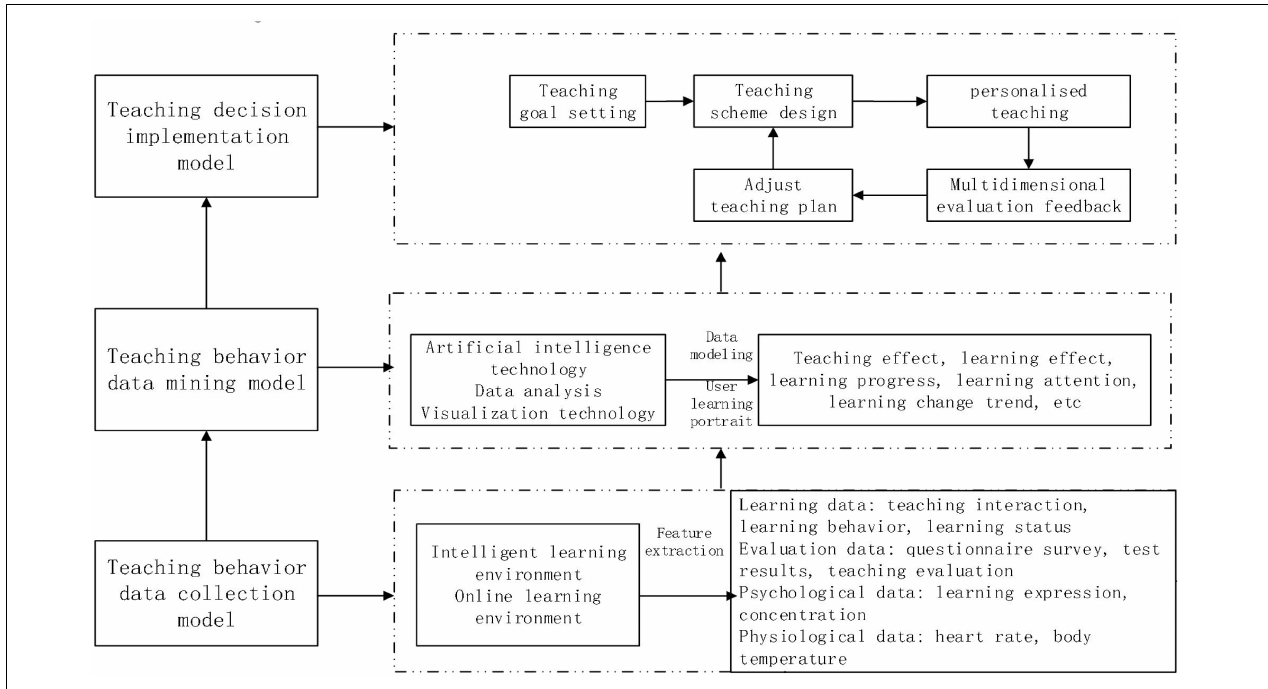
FIGURE 2 | Teaching decision-making scheme of a minority language